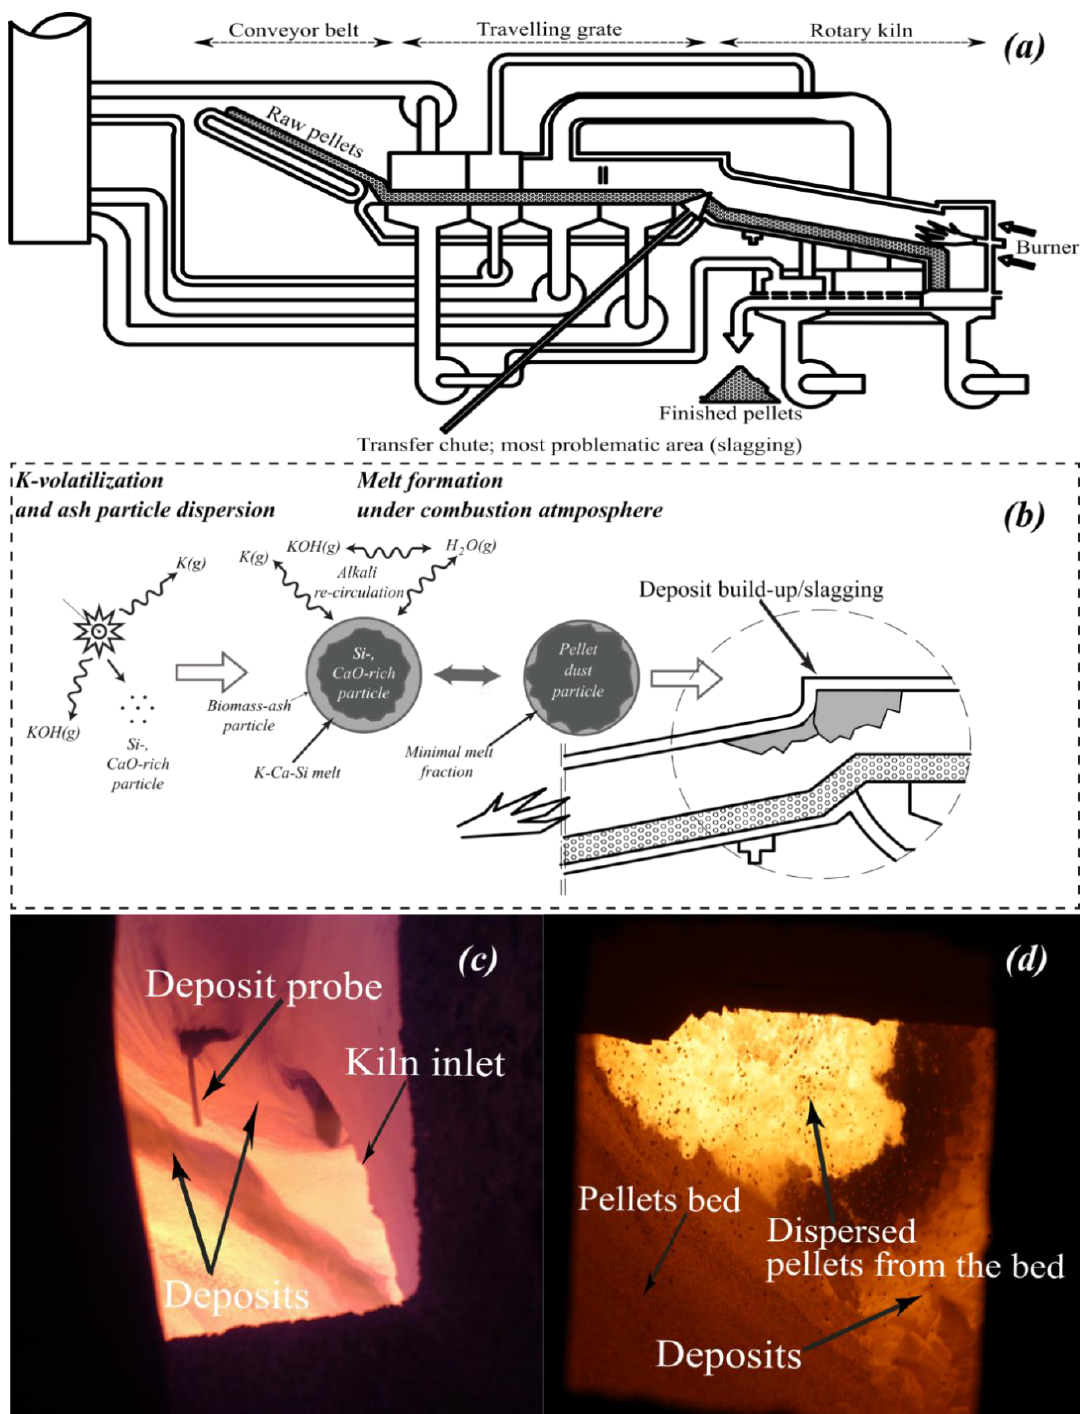
Figure 2. ( a ) Schematic of a typical grate-kiln setup indicating the regions of interest, i.e., transfer-chute and rotary kiln; ( b ) presumed ash transformation scheme associated with biomass combustion in iron-ore pelletizing; ( c ) slagging/deposition at the transfer-chute, deposits amassed on the sidewalls and within the glowing pellet bed; ( d ) fireside slagging in the vicinity of the flame with dispersed pellets from the tumbling pellet bed.